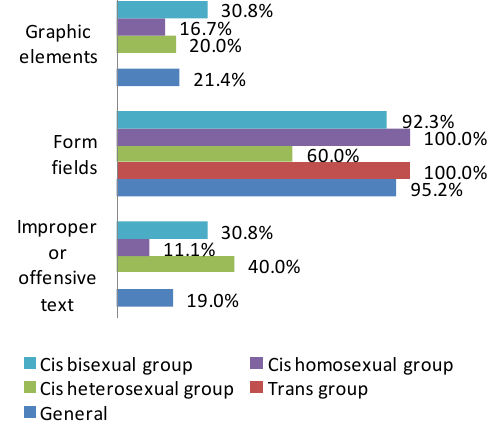
Fig. 2 – Proportion of each group that perceived oppressions in each